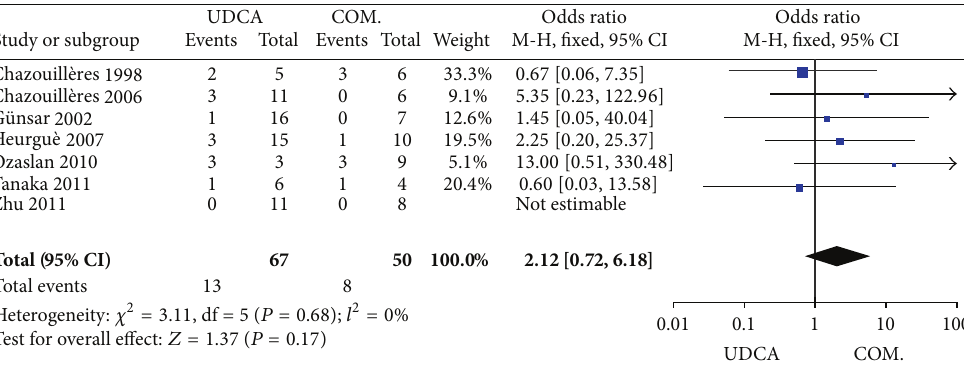
Figure 2: Effects of monotherapy versus combination therapy on pruritus and jaundice in patients with PBC-AIH.